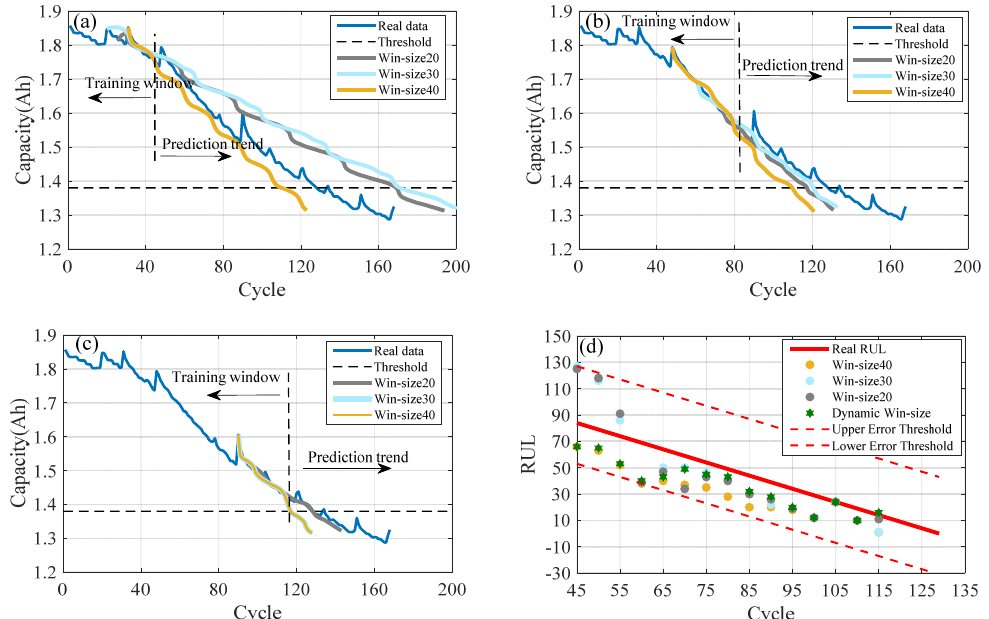
Figure 3. RUL prediction results of No. 05 with a dynamic window size: ( a ) prediction starting cycle of 42; ( b ) prediction starting cycle of 82; ( c ) prediction starting cycle of 118; ( d ) RUL prediction results.